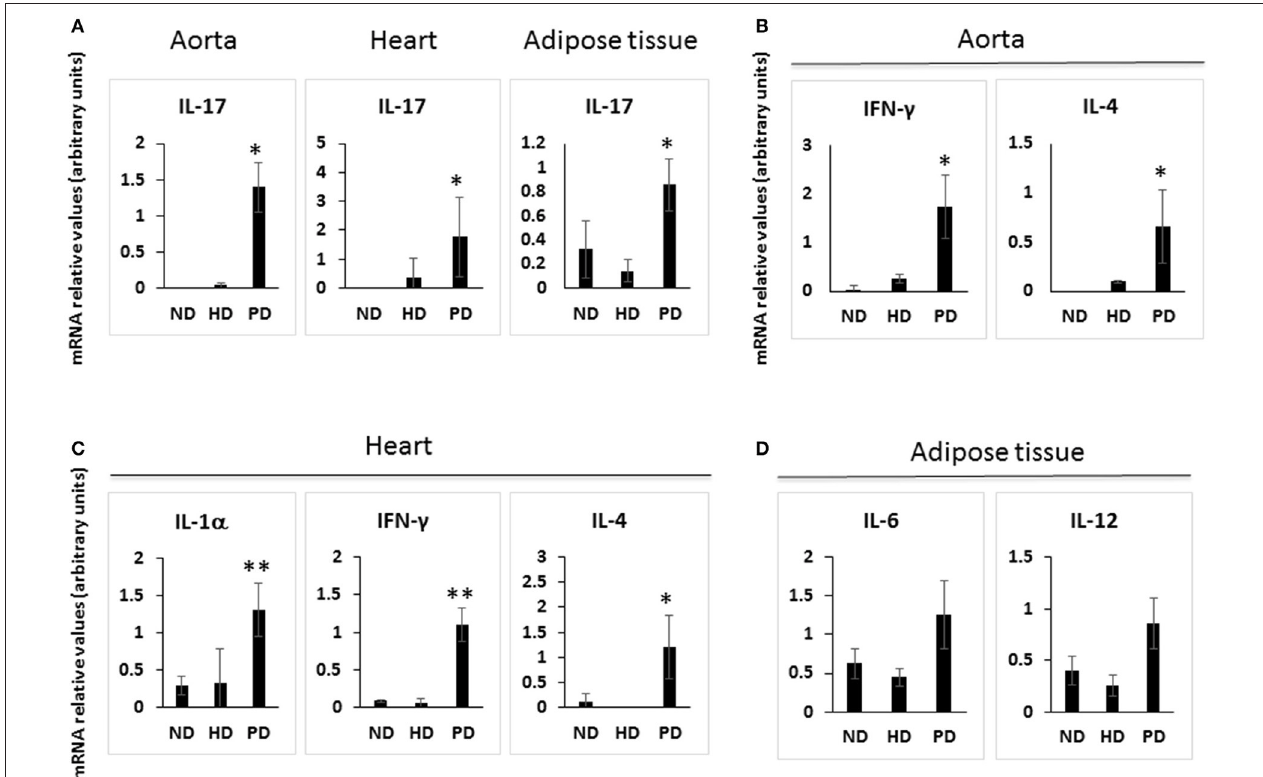
FIGURE 5 | Cytokine gene expression in the tissues of Normal diet (ND)-, High fat diet (HD)-, and Paigen diet (PD)-fed mice. Single cell suspensions were prepared from solid tissues (aorta, heart, and abdominal fat), and used for total RNA extraction and for qPCR. Relative quantification of IL-17A, IFN- γ , IL-4, TGF- β , IL-1 α , IL-12, and IL-6 mRNA levels were performed using the comparative CT method with normalization to GAPDH; results were expressed as fold difference relative to a relevant control sample. (A) IL-17 mRNA levels in the aorta, heart and adipose tissue. (B) IFN- γ and IL-4 mRNA levels in the aorta. (C) IL-1 α , IFN- γ , and IL-4 mRNA levels in the heart. (D) IL-6 and IL-12 mRNA levels in the adipose tissue. N = 3–4. * p < 0.05; ** p < 0.01.